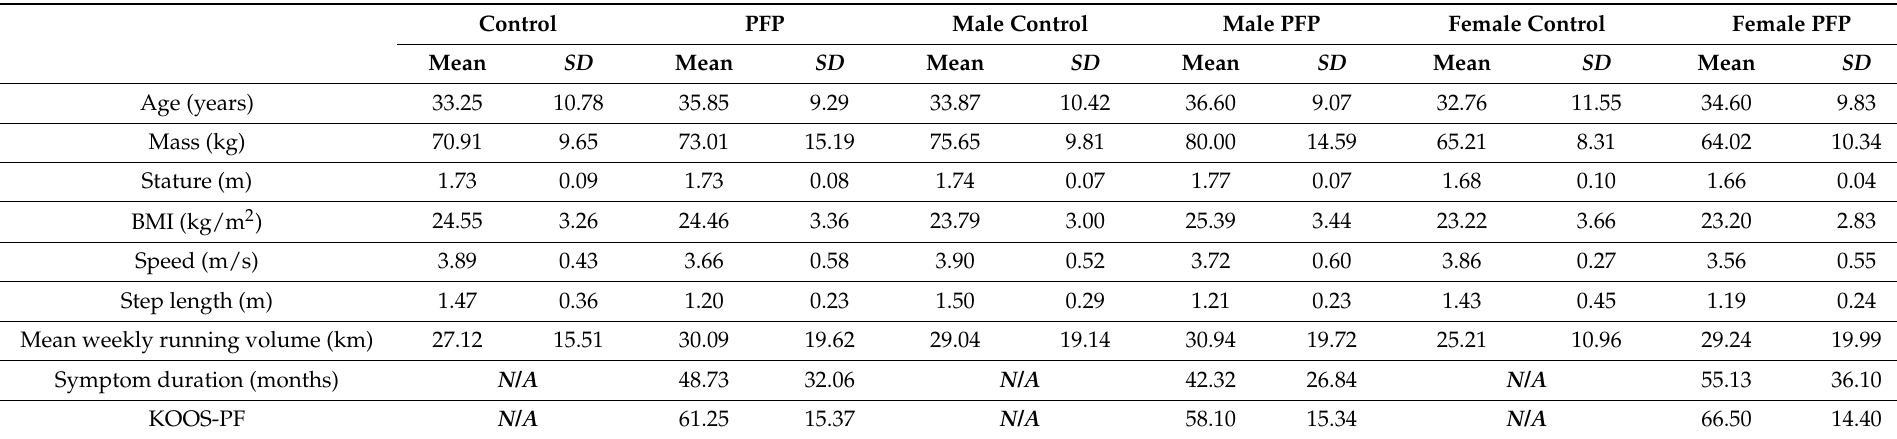
Table 1. Participant characteristics.